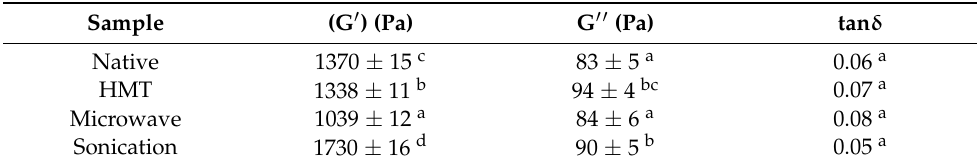
Table 4. Rheological properties of native and modified starches during frequency sweep test.